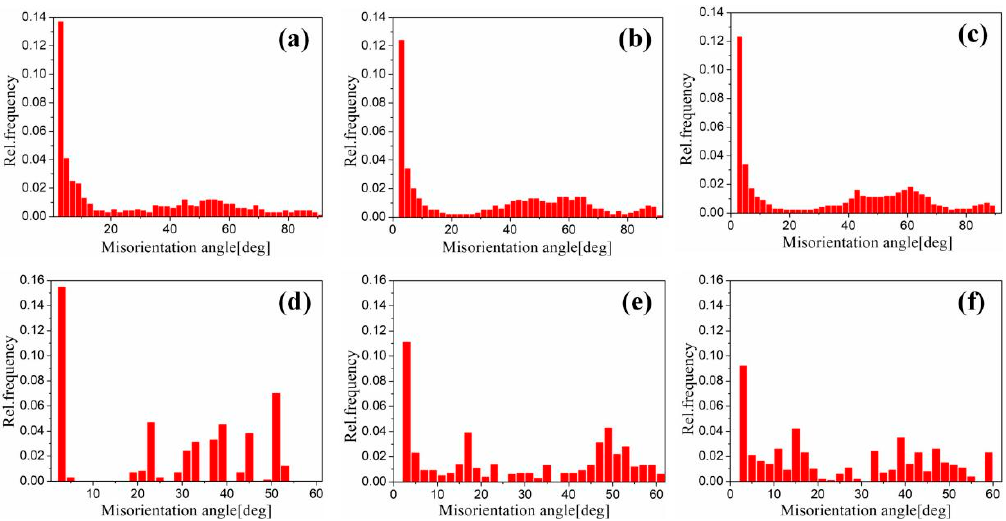
Figure 17. EBSD grain boundaries near the interface. ( a ) Specimen B3; ( b ) specimen C3. Lime green, black, red, blue and purple correspond to LAGBs (2° < misorientation angle < 15°), HAGBs (misori- entation angle > 15°), 65° <011 respectively.